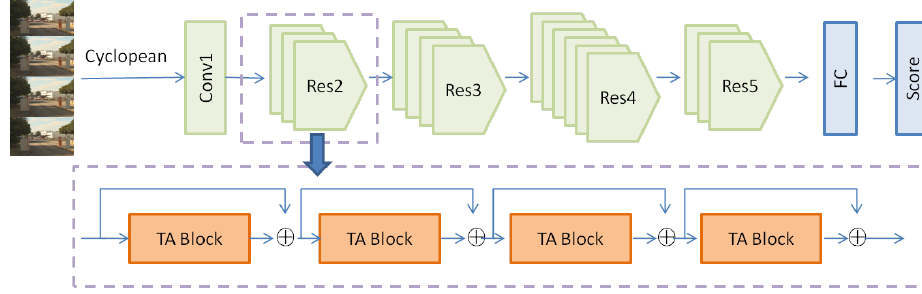
Figure 1. The overall framework of